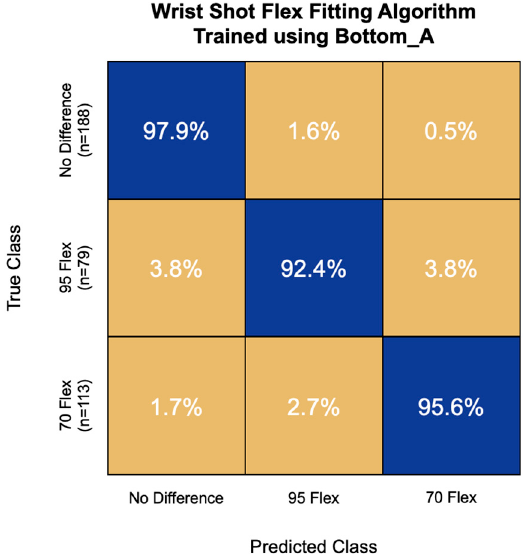
Figure 9. Confusion matrix of the flex fitting algorithm for wrist shot speed trained using bottom hand resultant linear acceleration (Bottom_A) signal features. Overall model accuracy was 96.1%.